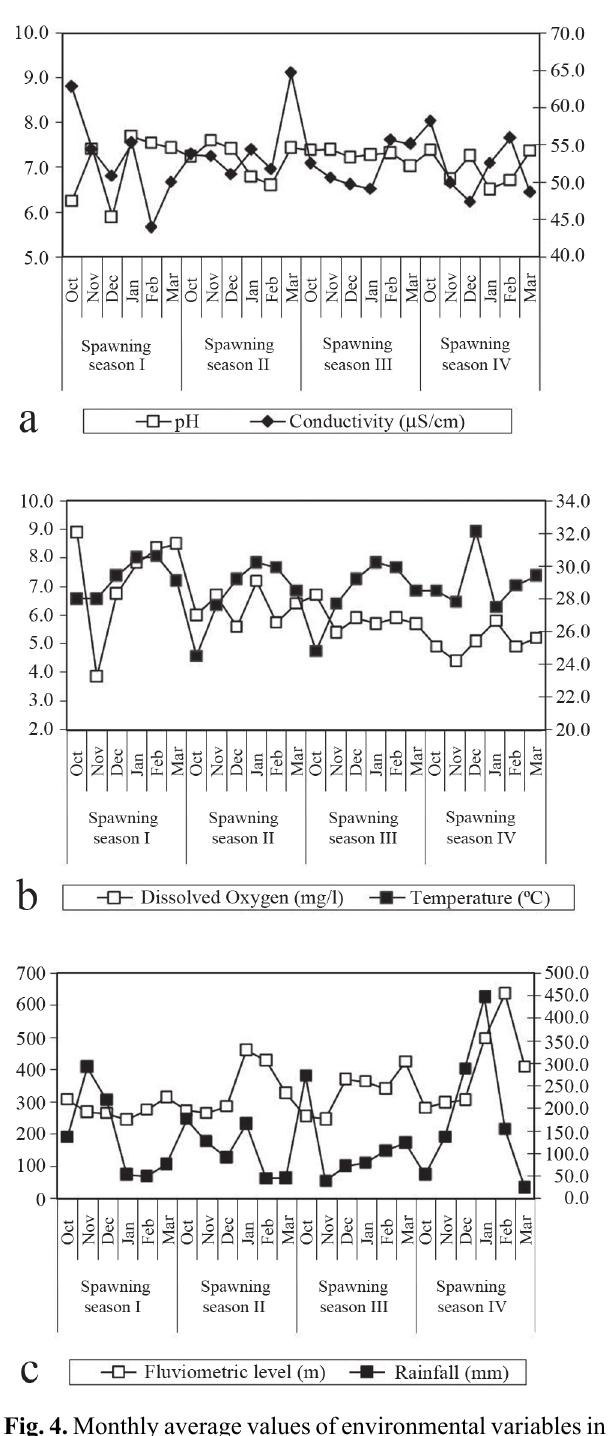
Fig. 4. Monthly average values of environmental variables in different spawning periods in Ilha Grande National